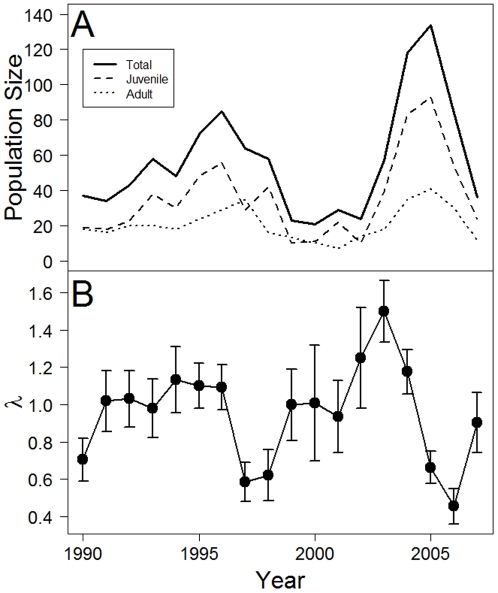
Annual population size and growth rates.(A) Total, juvenile, and adult population sizes and (B) deterministic population growth rate (λ ± SE) for a golden mantled ground squirrel population at the Rocky Mountain Biological Laboratory, Crested Butte, Colorado, for each year of the study.